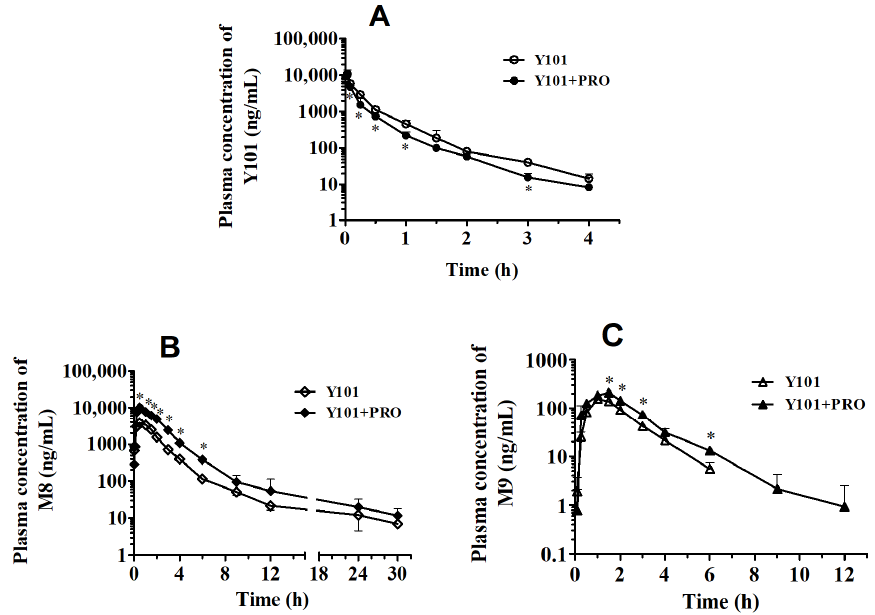
Figure 1. Mean plasma concentration–time curves of Y101 ( A ), M8 ( B ) and M9 ( C ) after intravenous administration of Y101 (25 mg/kg) or Y101 + PRO (100 mg/kg). Data are expressed as mean ± SD (* p < 0.05 vs. Y101 group; n = 3).